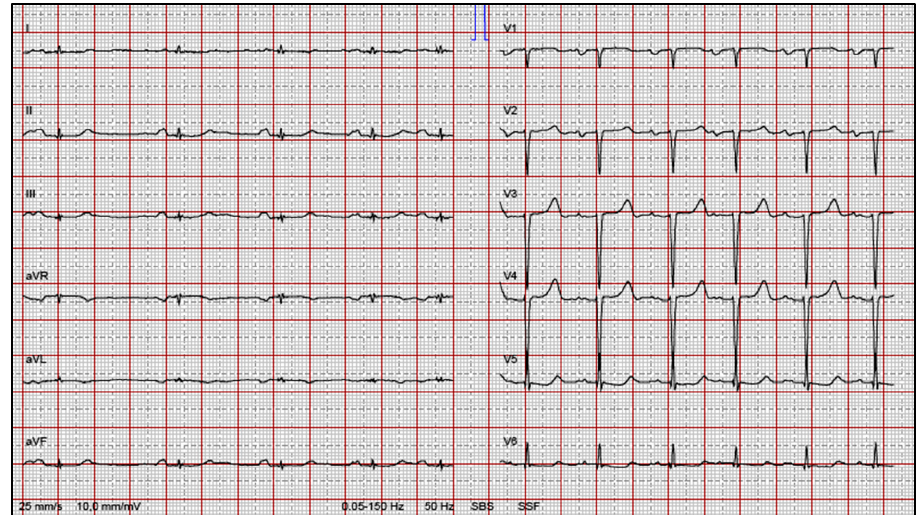
Figure 3. 12-lead surface ECG of a 77-year-old male patient with AL, demonstrating low voltages on extremity leads, left atrial abnormality as well as poor R-wave progression on precordial